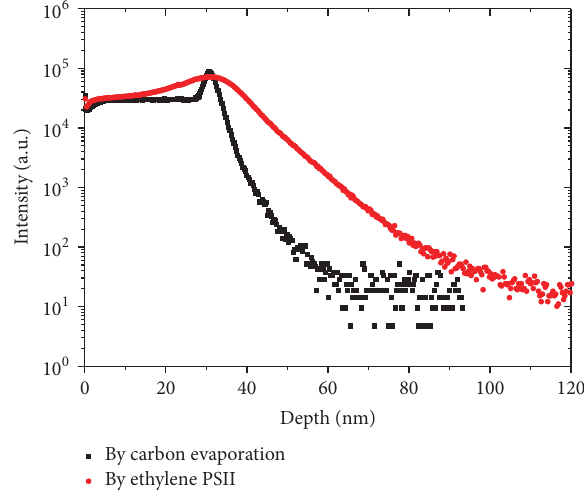
Figure 2: SIMS depth profile of a carbon film, deposited by evaporation (black) and by ethylene PSII at − 15kV